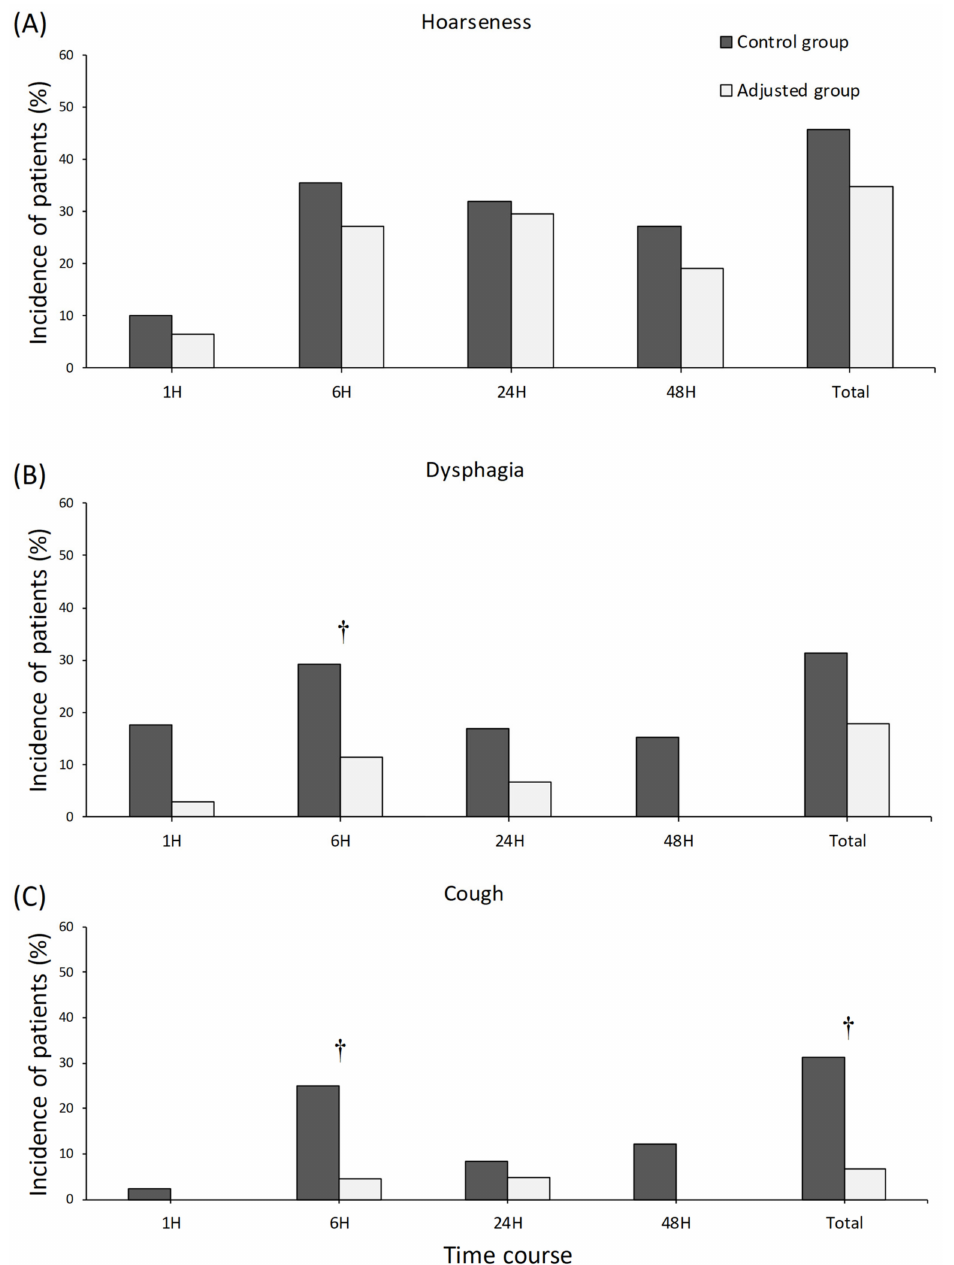
Figure 5. The incidence of laryngo-pharyngeal complications. ( A ) Hoarseness; ( B ) Dysphagia; ( C ) Cough. The incidence of dysphagia and cough 6 h postoperatively was lower in the adjusted group than in the control group (11.4% vs. 29.2%, p = 0.035; 4.5% vs. 25%, p = 0.006). The total incidence of cough was lower in the adjusted group than in the control group (6.7% vs. 31.3%, p = 0.003). † p <